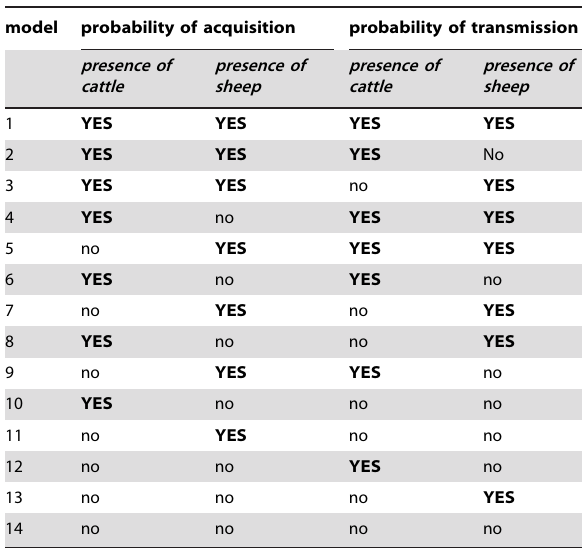
Table 3. Summary of demographic factors included in models for the probability of transmission of BTV between